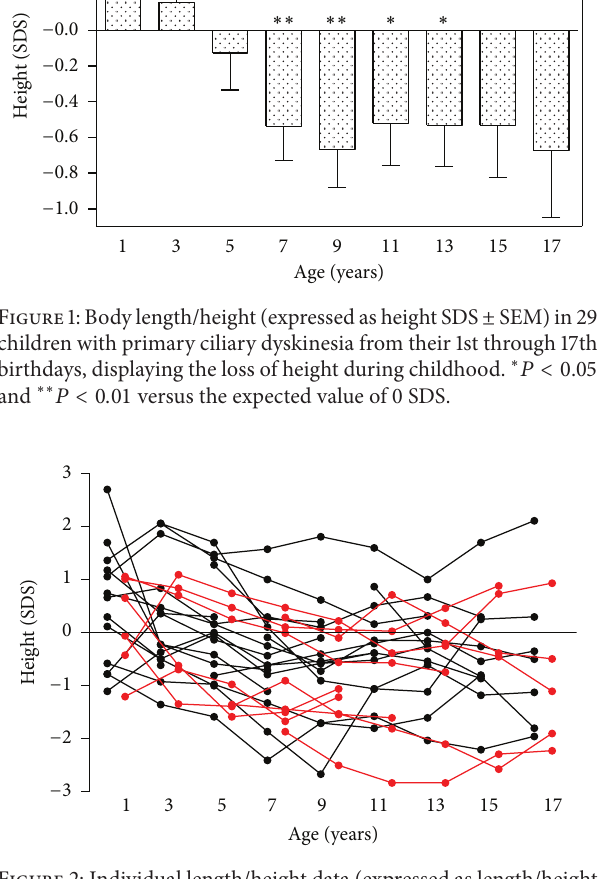
Figure 2: Individual length/height data (expressed as length/height SDS) obtained from the GPs’ records of 29 children with primary ciliary dyskinesia. In red are patients with pathogenic mutations on both alleles of DNAH5 or DNAI1 ; in black are all other patients with a clinical diagnosis of